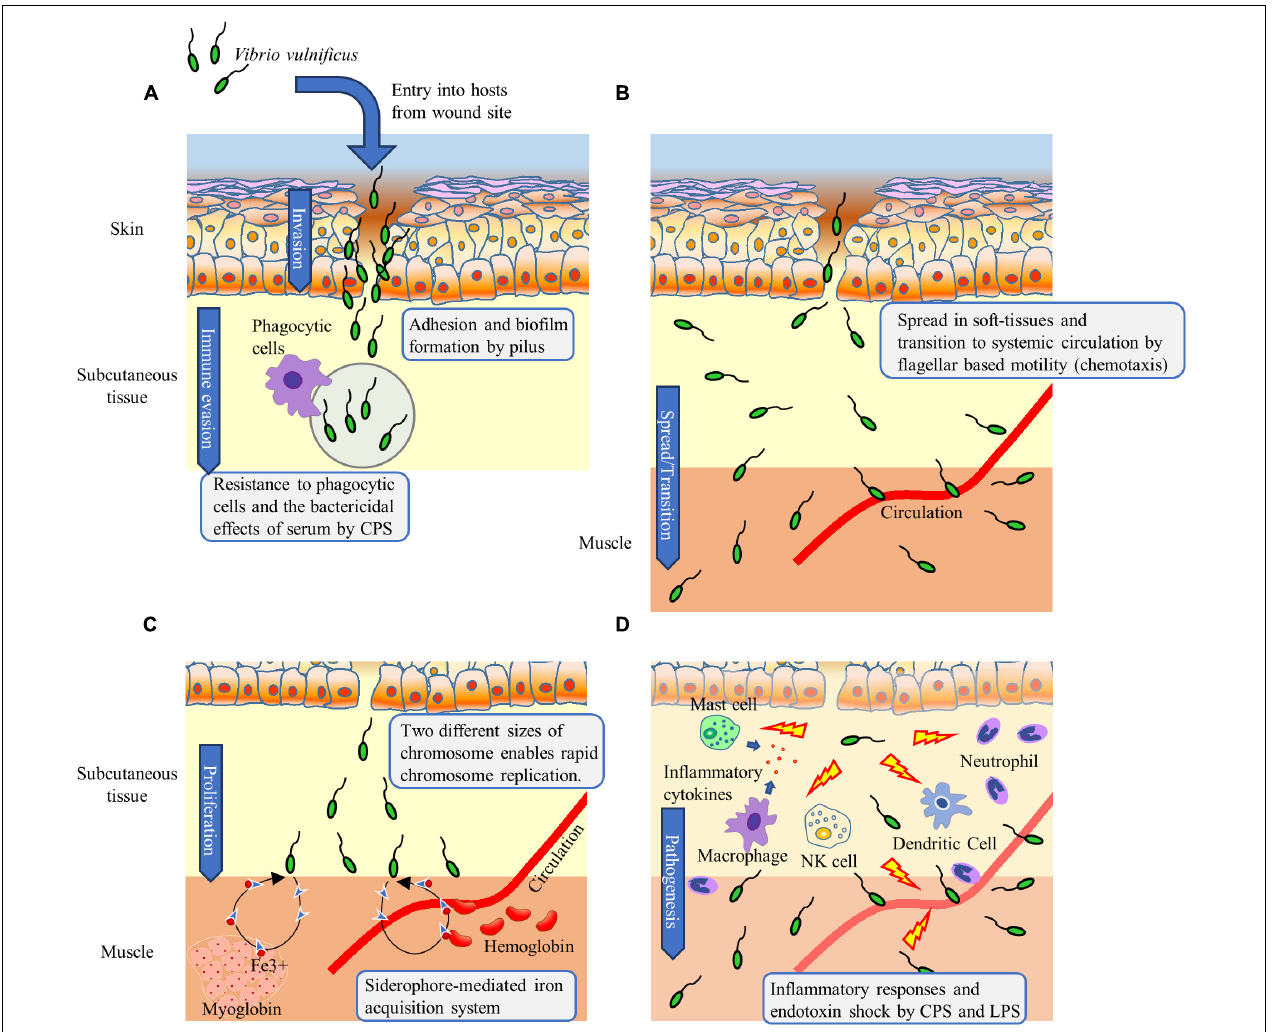
FIGURE 7 | STM screening reveals the essential factors whereby V. vulnificus invades, spreads, proliferates, and causes wound infection. (A) V. vulnificus adheres to cells located at the local wound infection site via the pilus. Biofilm formation and CPS contribute to resistance against immune cells. (B) V. vulnificus spreads in soft-tissues by flagellar based motility based on chemotaxis. (C) Two different sizes of chromosomes enable rapid chromosome replication leading to rapid cell division and proliferation. Iron, which is an essential element in bacterial metabolic and informational cellular pathways, is acquired via a siderophore-mediated system. (D) CPS and LPS induce inflammation-associated cytokines leading to septic